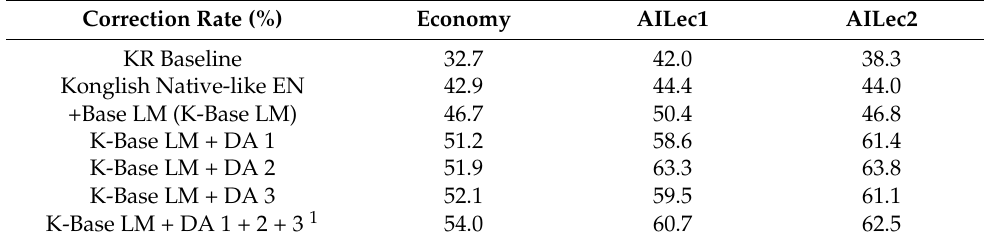
Table 7. ASR correction rate of English words with Hangul in Korean and English CS